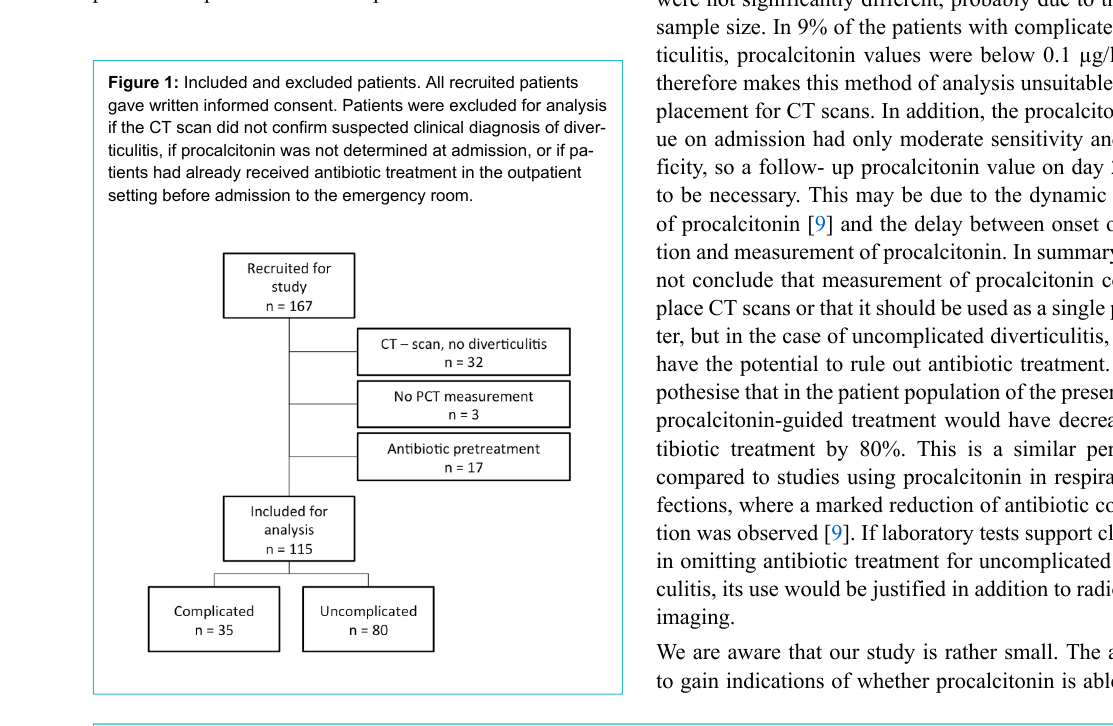
Figure 2: ROC (receiver operating characteristic) curve of procalcitonin against the gold standard of abdominal CT scan. The highest procalci- tonin serum concentration of day 1 (admission) or day 2 showed a sensitivity of 80% and a specificity of 91%. AUC is indicated with 95% con- fidence interval in